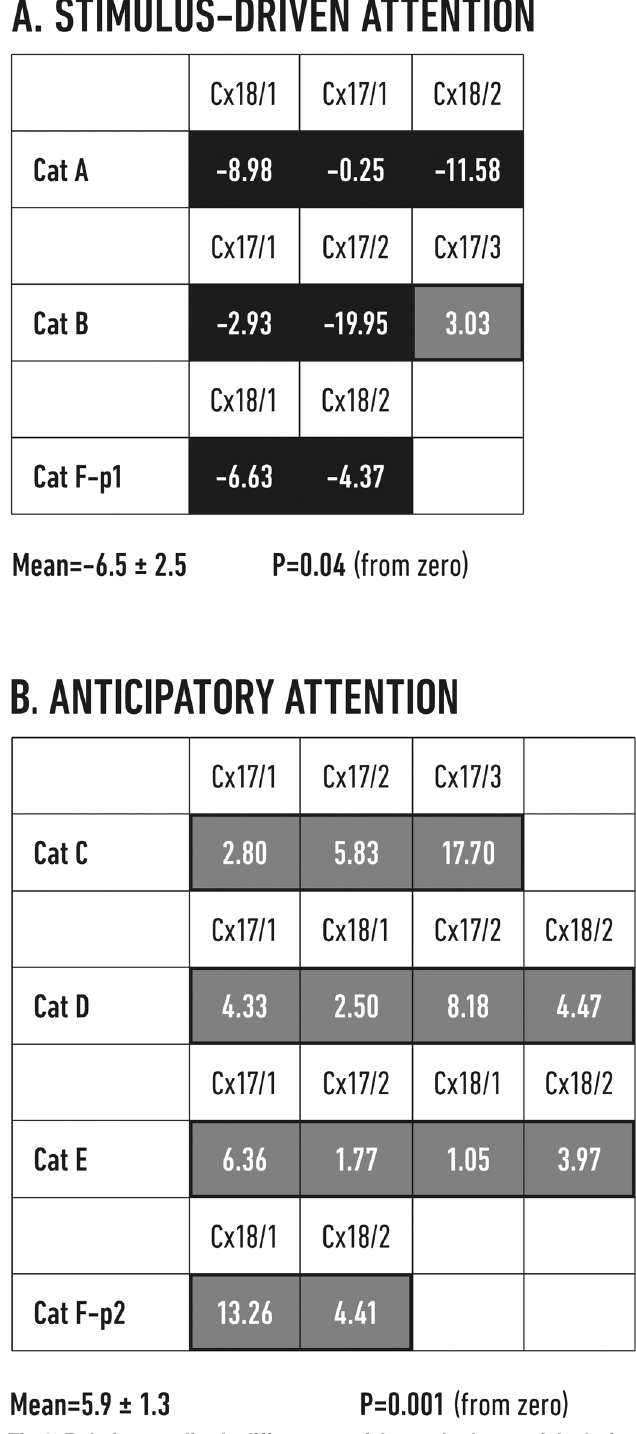
Fig 4. Relative amplitude differences of the evoked potentials during high and low beta states in visual trials. EPs induced by chiasmatic stimulation during visual trials were analyzed in all recording sites and all cats in the two experimental paradigms (cf. Table 1) — A stimulus driven attention, B — anticipatory attention. Each box shows the normalized percentage difference ( Δ %) between the EP amplitudes calculated for the appropriate recording site: Δ % = 100% x (high − low) / low, where “ high ” indicates the mean amplitude of the EPs that were preceded by bursts of high beta activity and “ low ” refers to the mean amplitude of the